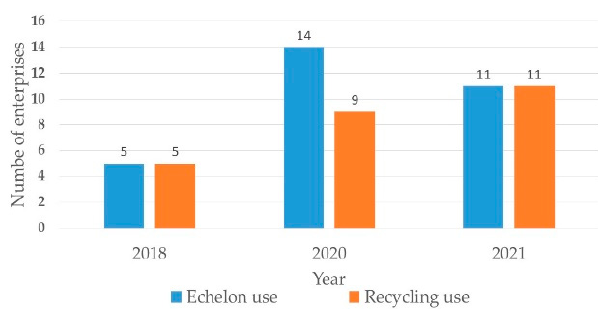
Table 2. Performance comparison of the three batteries.